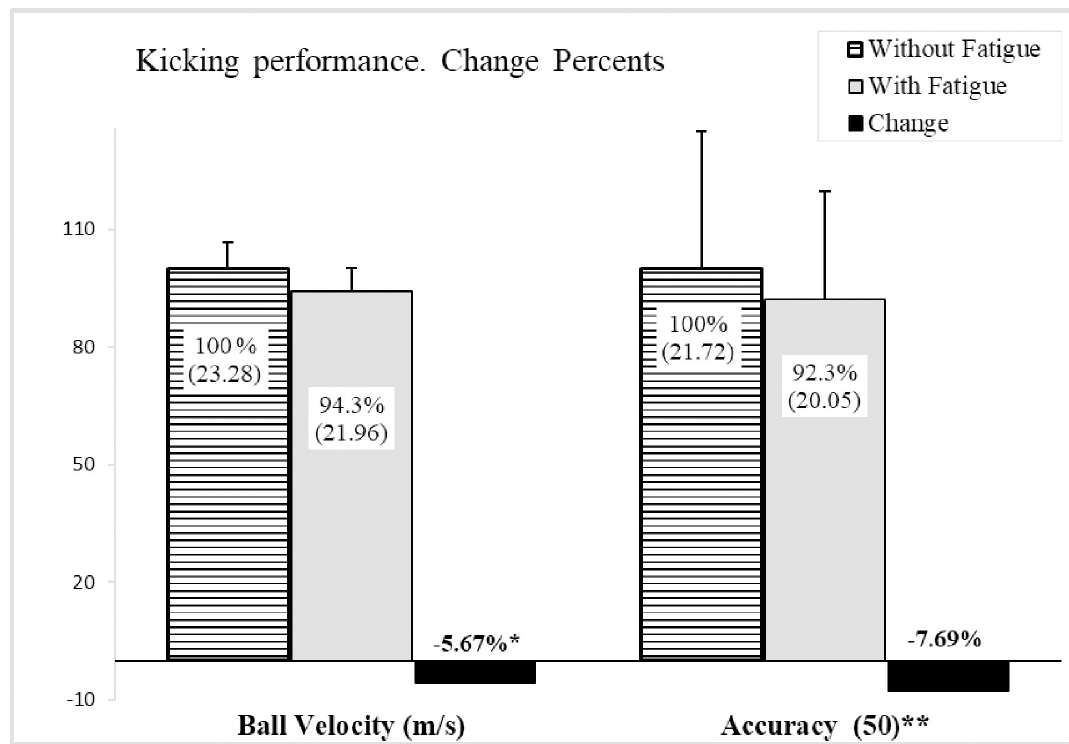
Fig 2. Kicking variables. Percent Relative changes according to "without fatigue" values. � significant differences (Paired sample t- test). �� maximum possible score in accuracy.